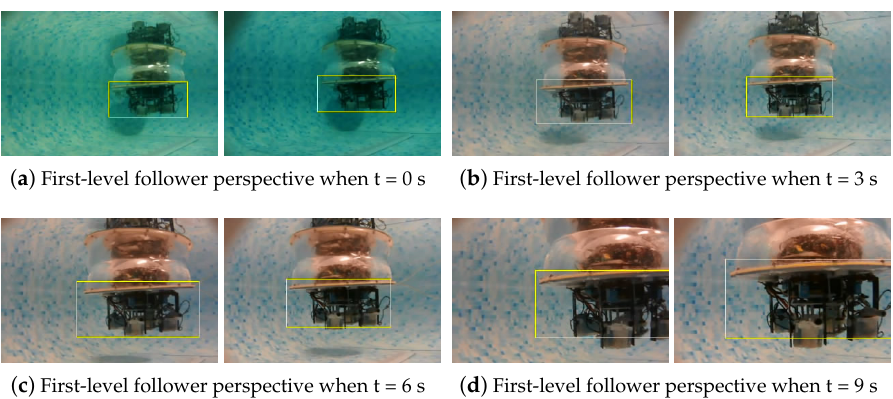
Figure 27. Images of global perspective and follower perspective of the three-robot “round-up hunting” formation experiment.